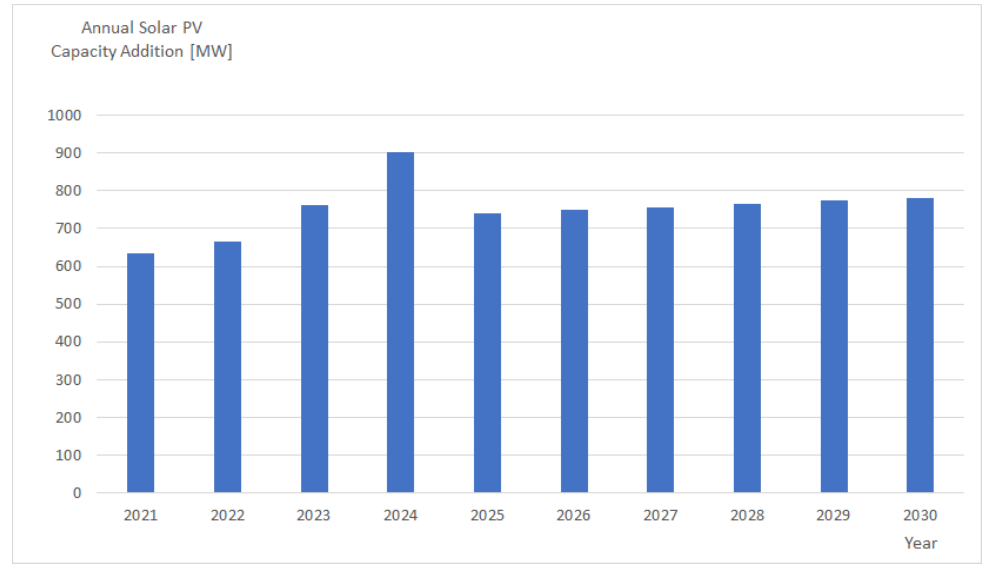
Figure 4. Forecast of solar PV capacity installation in Portugal until 2030. Adapted from [72].